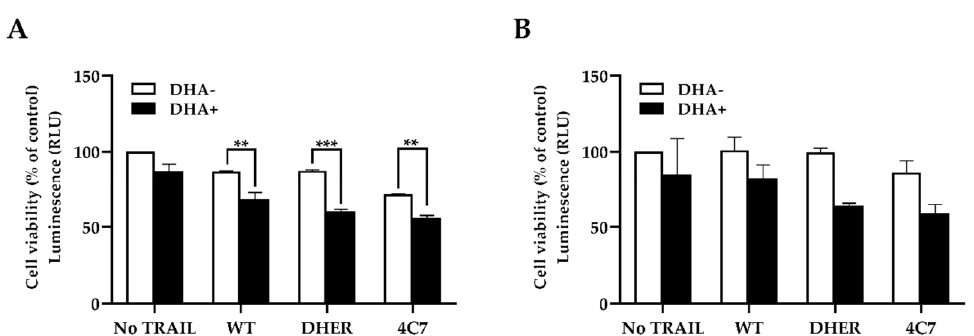
Figure 8. DHA sensitizes HCT116 and DLD-1 spheroids to TRAIL-induced apoptosis. The 3D spheroids of HCT116 ( A ) and DLD-1 ( B ) were constructed in ultra-low attachment 96-well plates after 72 h incubation. Then, the spheroids were treated with 10 µ M DHA for 30 min, followed with/without 25 ng/mL rhTRAIL WT, DHER, or 4C7 for 24 h. The cell viability of the spheroids was determined after 25 min incubation with CellTiter-Glo ® 3D Reagent. Data shown are mean ± SEM from three independent experiments performed in triplicate. p values were analyzed by two-way ANOVA with Sidak’s multiple comparisons test with Graphpad Prism version 8.0. ** 0.001 < p ≤ 0.01, *** 0.0001 < p ≤ 0.001.